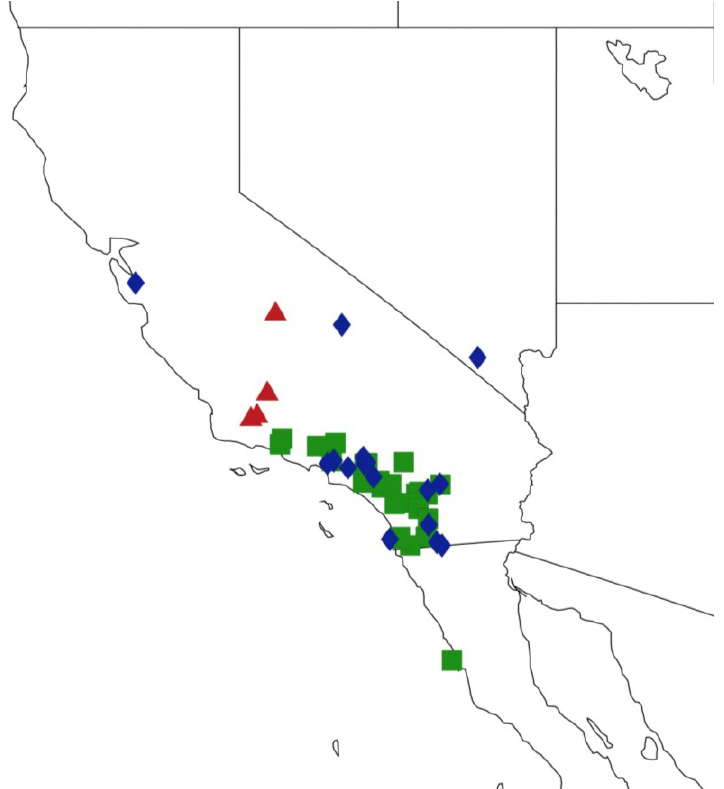
Figure 45. Distribution of Clidophleps beameri (red triangles), C. wrighti (green squares) and C. tenuis (blue diamonds).